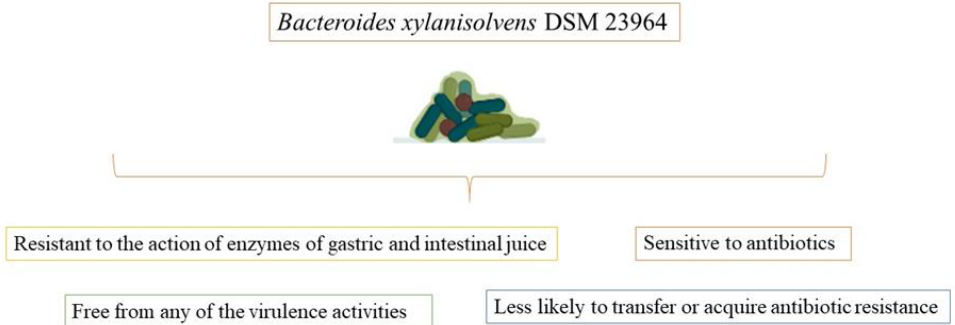
Figure 2. Potential promising advantages of Bacteroides xylanisolvens DSM 23964 strain in food fer- mentation